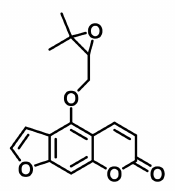
Figure 1. The chemical structure of